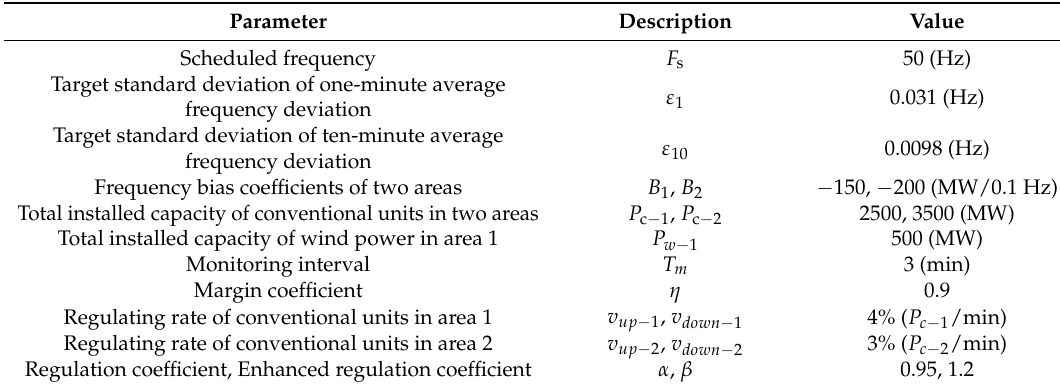
Table 3. Control actions under different conditions.